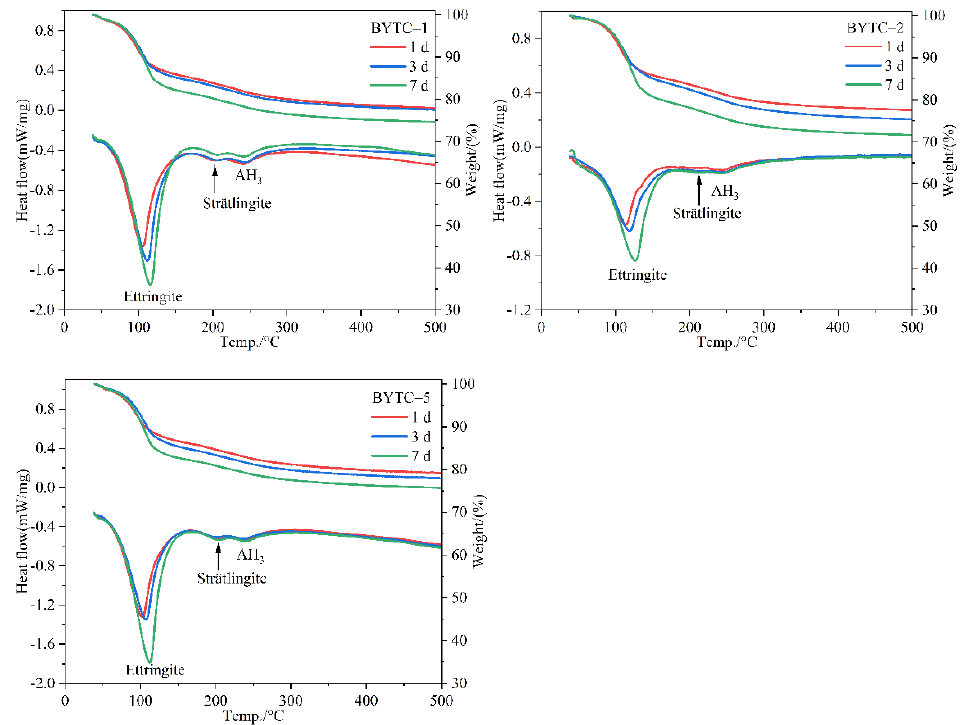
Figure 5. TG-DSC curves of BYT cements hydration for 1 d, 3d and